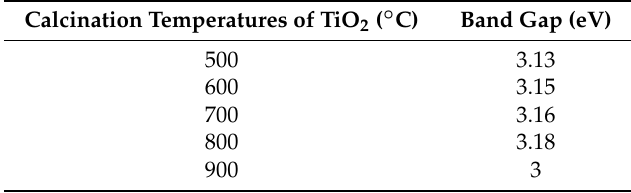
Table1. Band gap of TiO2 nanoparticles calcined at different Table 1. Band gap of TiO2 nanoparticles calcined at different temperatures.